Question: What kind of plot is shown here?
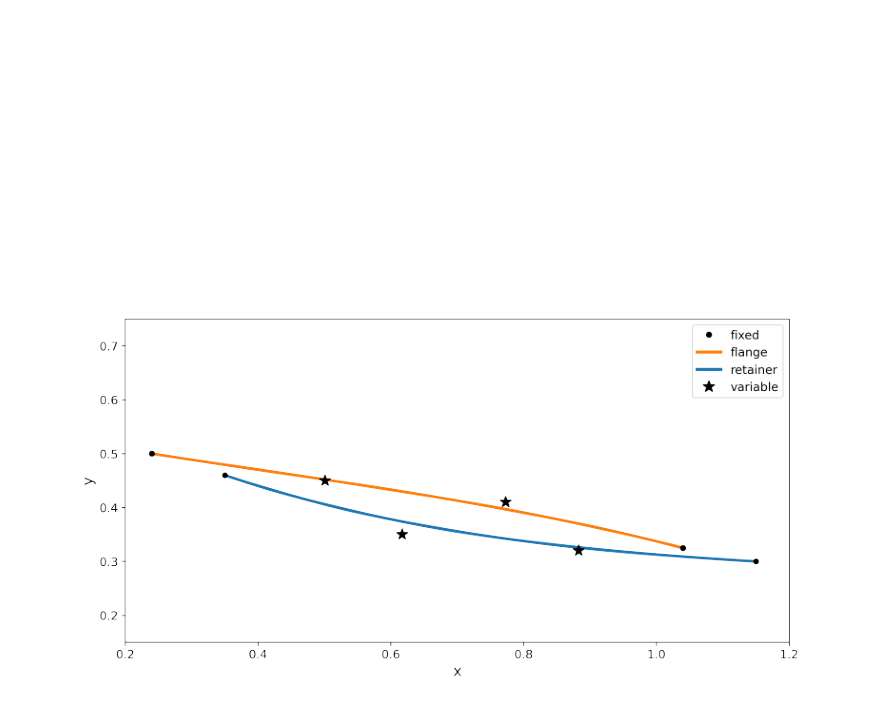
Answer: line